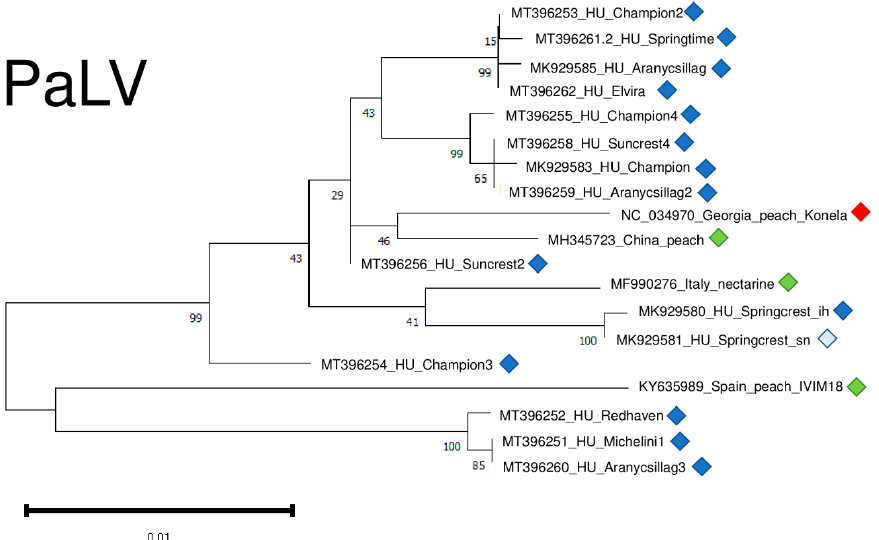
Figure 12. Evolutionary analysis of 1132 bp long part of the PaLV genome encoding partial ORF3a, CP and MP of different PaLV isolates by Maximum Likelihood method. The evolutionary history was inferred by using the Maximum Likelihood method and Tamura-Nei model. The tree with the highest log likelihood ( − 2214.35) is shown. The percentage of trees in which the associated taxa clustered together is shown below the branches. Initial tree(s) for the heuristic search were obtained automatically by applying Neighbour-Join and BioNJ algorithms to a matrix of pairwise distances estimated using the Tamura-Nei model, and then selecting the topology with superior log likelihood value after 1000 Bootstraps. The tree is drawn to scale, with branch lengths measured in the number of substitutions per site. Alignment of the sequences was done using MUSCLE. Evolutionary analyses were conducted in MEGA11. The red box is the reference genome, green boxes indicate PaLV strains from the NCBI GenBank, Hungarian PaLV strains are indicated with dark blue (originating from the isolator house) and light blue (originating from the open field stock nursery).